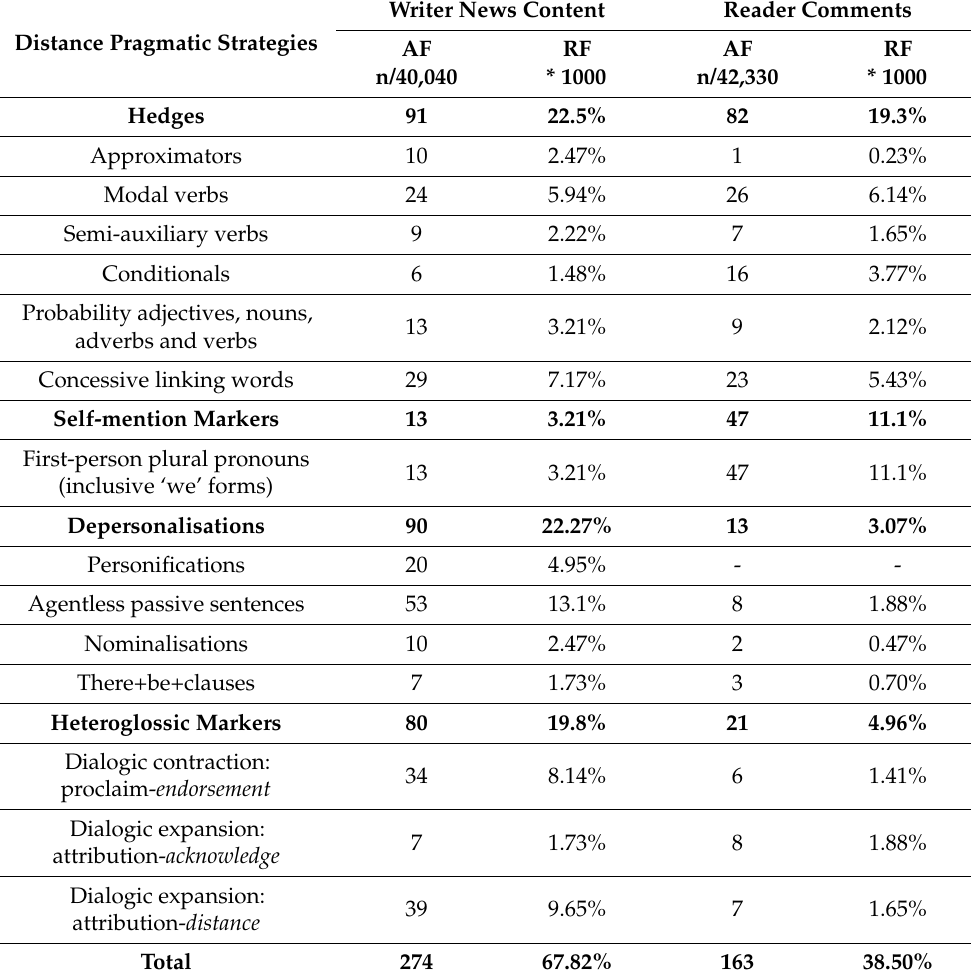
Table 3. Frequencies in the use of distance pragmatic strategies in the two corpora. Writer News Distance Pragmatic Strategies